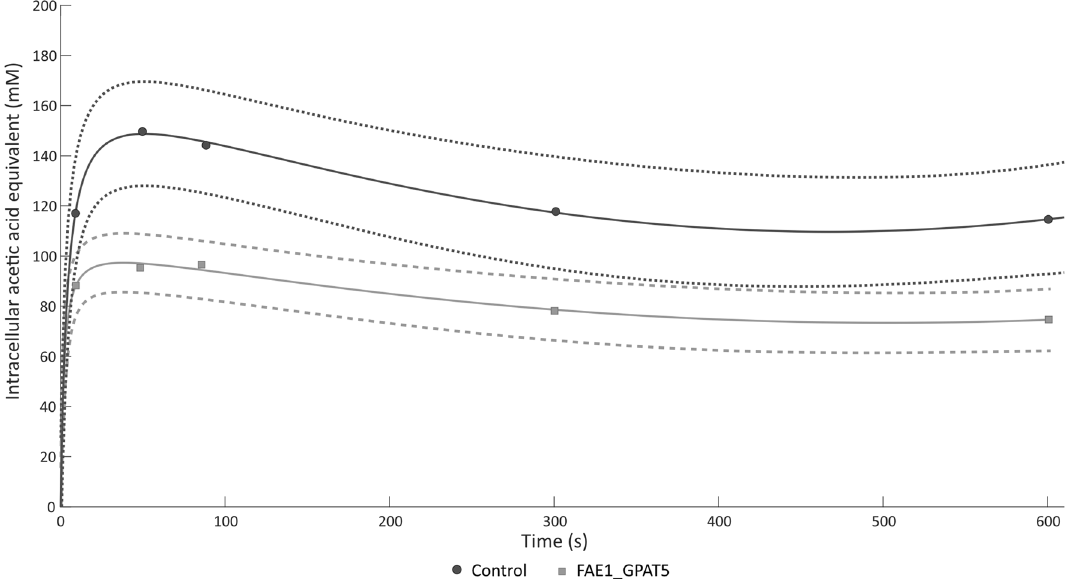
Figure 4. Acetic acid uptake with an initial extracellular acetic acid concentration of 144 mM, pH 5.0. Rational regression lines were calculated using MATLAB and the 90% confidence intervals are shown by the dotted lines. The average sample response is given at each time point measured (10, 45, 80, 300 and 600 s). The control strain is depicted in black, while the FAE1_GPAT5 double expression strain is shown in grey.